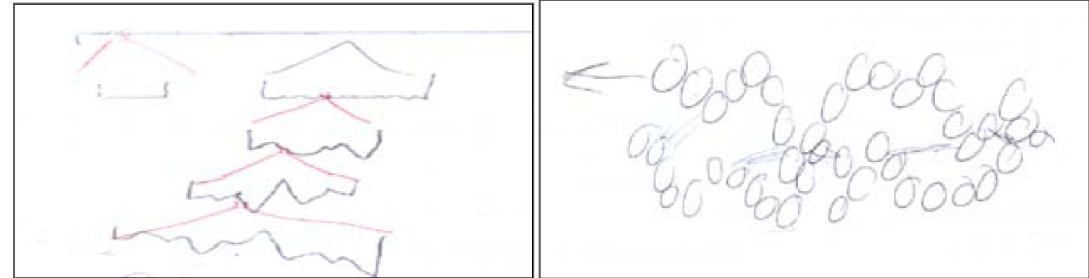
FIG. 3 (color online). Typical sketch by students of surfaces at different length